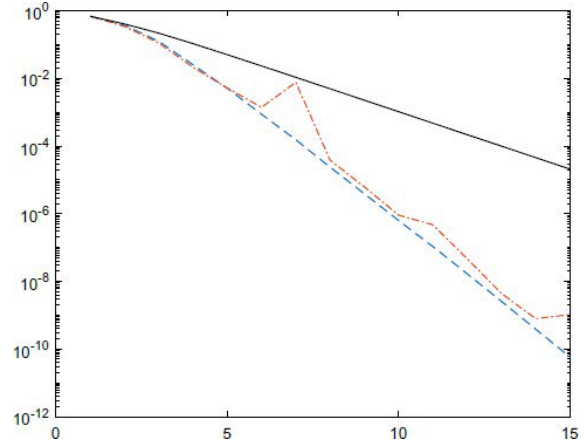
Fig. 6 Comparison of algorithm curve and theoretical solution curve in this paper